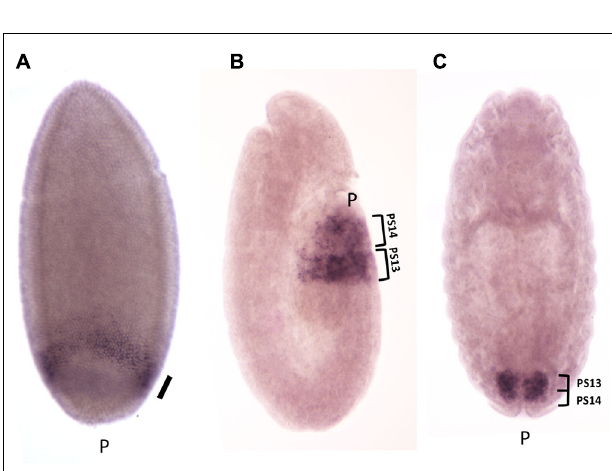
rearrangement breakpoints that disrupt the abdominal region of the BX-C. Breaks in red fail to complement the sterility phenotype of Δ miRNA, while break in green are fully fertile over Δ miRNA.The Fab-8 64 deletion removing the promoter of the iab-8 ncRNA is indicated by red brackets.